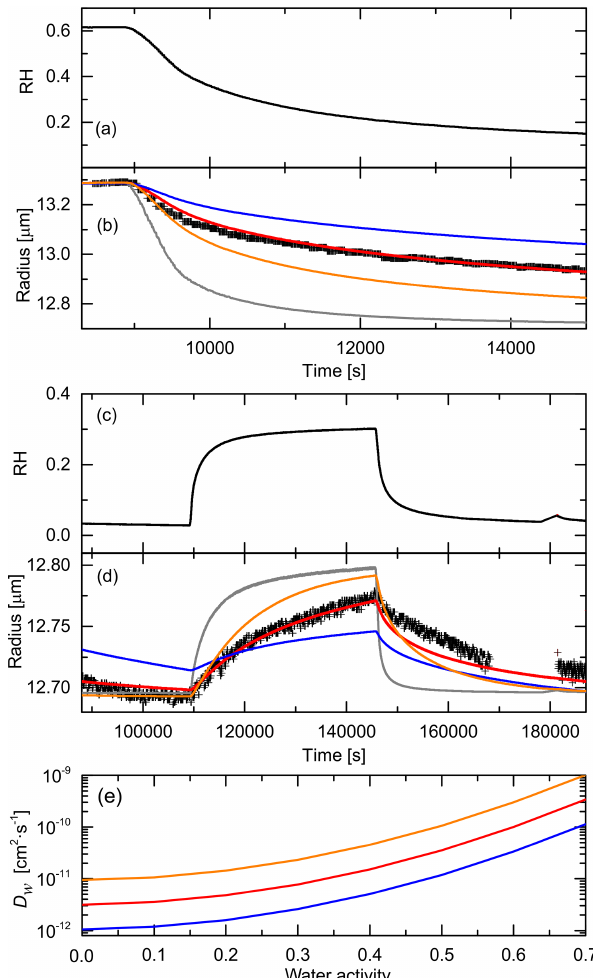
Figure 1. Experimental data of the hygroscopic response of an SOA particle levitated in the EDB at 263K that was initially equilibrated at 60% RH. (a) and (c) : change in RH upon drying and humid- ifying. (b) and (d) : corresponding size change measured by Mie- resonance spectroscopy (black crosses) together with the response expected based on the thermodynamic properties (gray lines) and the predictions from the diffusion model (red lines). The orange and blue lines represent the upper and lower limits of the uncer- tainty range associated with the concentration dependence of the water diffusion coefficients, D w , shown in panel (e) . The values of D w at water activity intervals of about 0.1 were used to produce the temperature and concentration dependent fit shown in Fig.